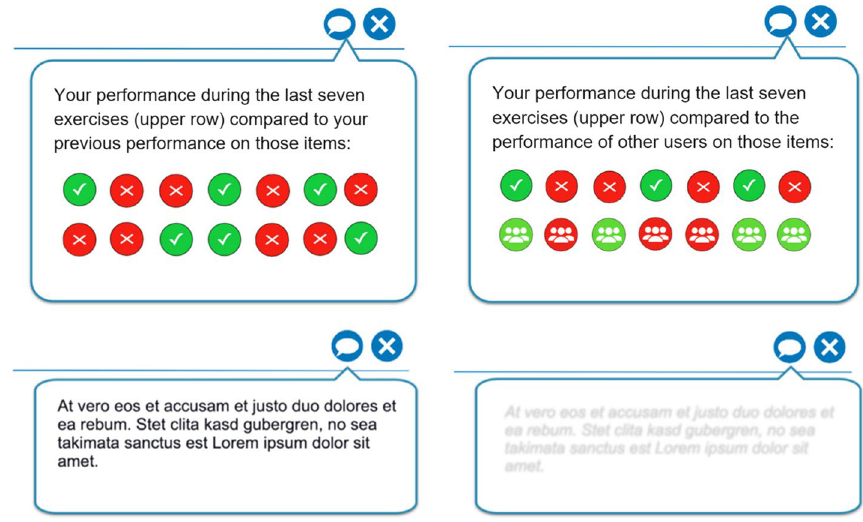
Fig. 3 Feedback types and fluency manipulations used in experiment 2. Top left right social feedback, bottom left =